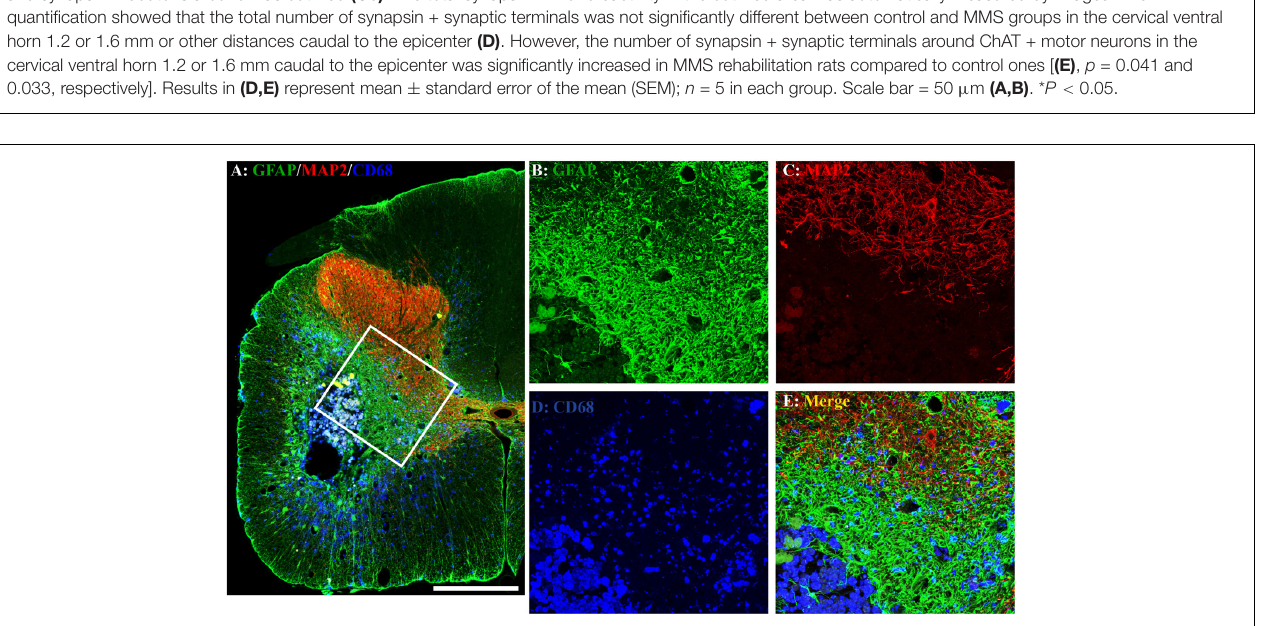
FIGURE 5 | Astrogliosis and neuroinflammation after chronic spinal cord injury (SCI). Astrogliosis, neuroinflammation, or spared gray matter were evaluated by an immunohistochemical staining method using antibody against glial fibrillary acidic protein (GFAP), an astrocyte-specific marker (A,B) , cluster of differentiation 68 (CD68), a marker for macrophage and active microglia (A,D) , or microtubule-associated protein 2 (MAP2), a neuronal specific marker (A,C) , respectively. In the injury area, the unilateral contusion resulted in the formation of a cavity, which was surrounded by an astroglial scar. The hypertrophied CD68 + macrophages were aggregated around the lesion border and scattered in the spared gray and white matters near the injury. A representative triple-immunostaining image was taken from the spinal cord 0.8 mm caudal to the epicenter of a Modified Montoya Staircase (MMS) rehabilitation rat (A) . The higher magnification images of the defined area [ (A) , white box] were shown in (B–E) for GFAP-IR, MAP2-IR, CD68-IR, or merged, respectively. Scale bar = 200 µ m in (A)